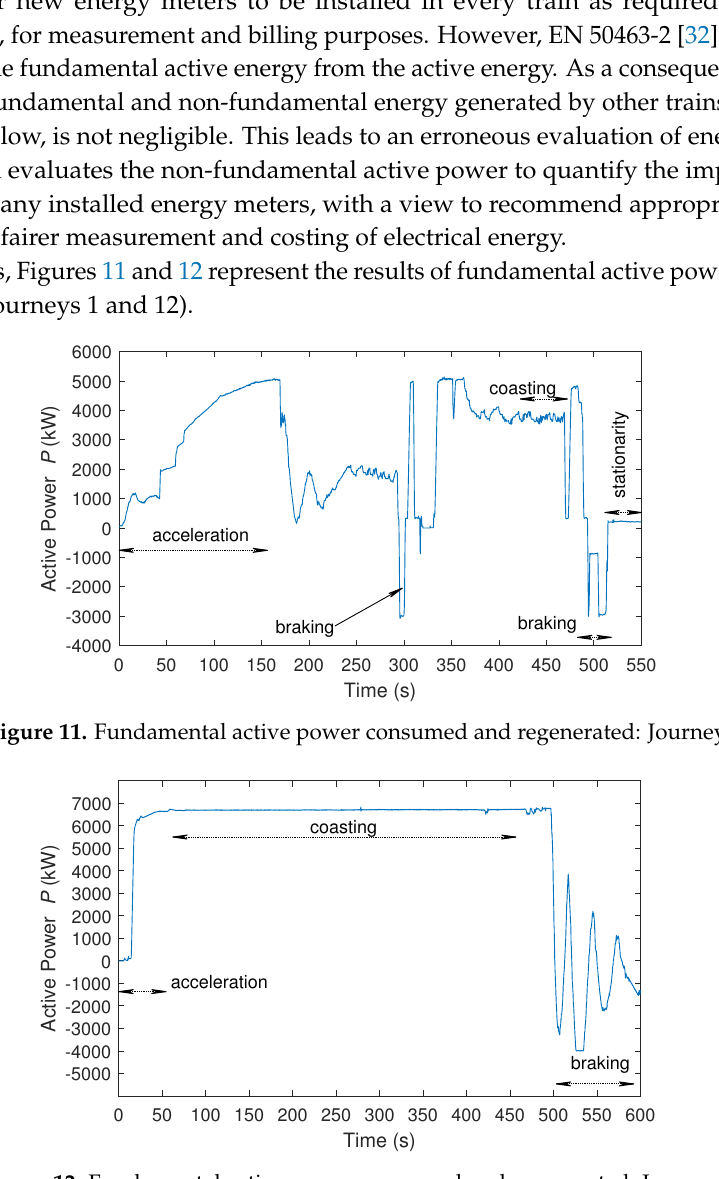
Figure 12. Fundamental active power consumed and regenerated: Journey